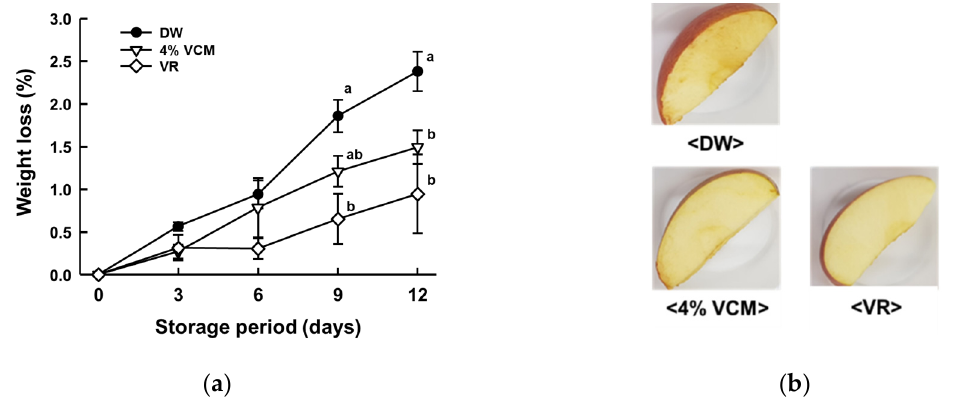
Figure 3. Change of weight loss and appearance of freshly cut apples. ( a ) Evaluation of weight loss in apples treated with DW, 4% VCM, and VR for 1 min. ( b ) Photographs of freshly cut apples according to the treatment conditions after 3 days. Statistical significance was determined using one-way analysis of variance (mean ± standard error [SE], n = 3).